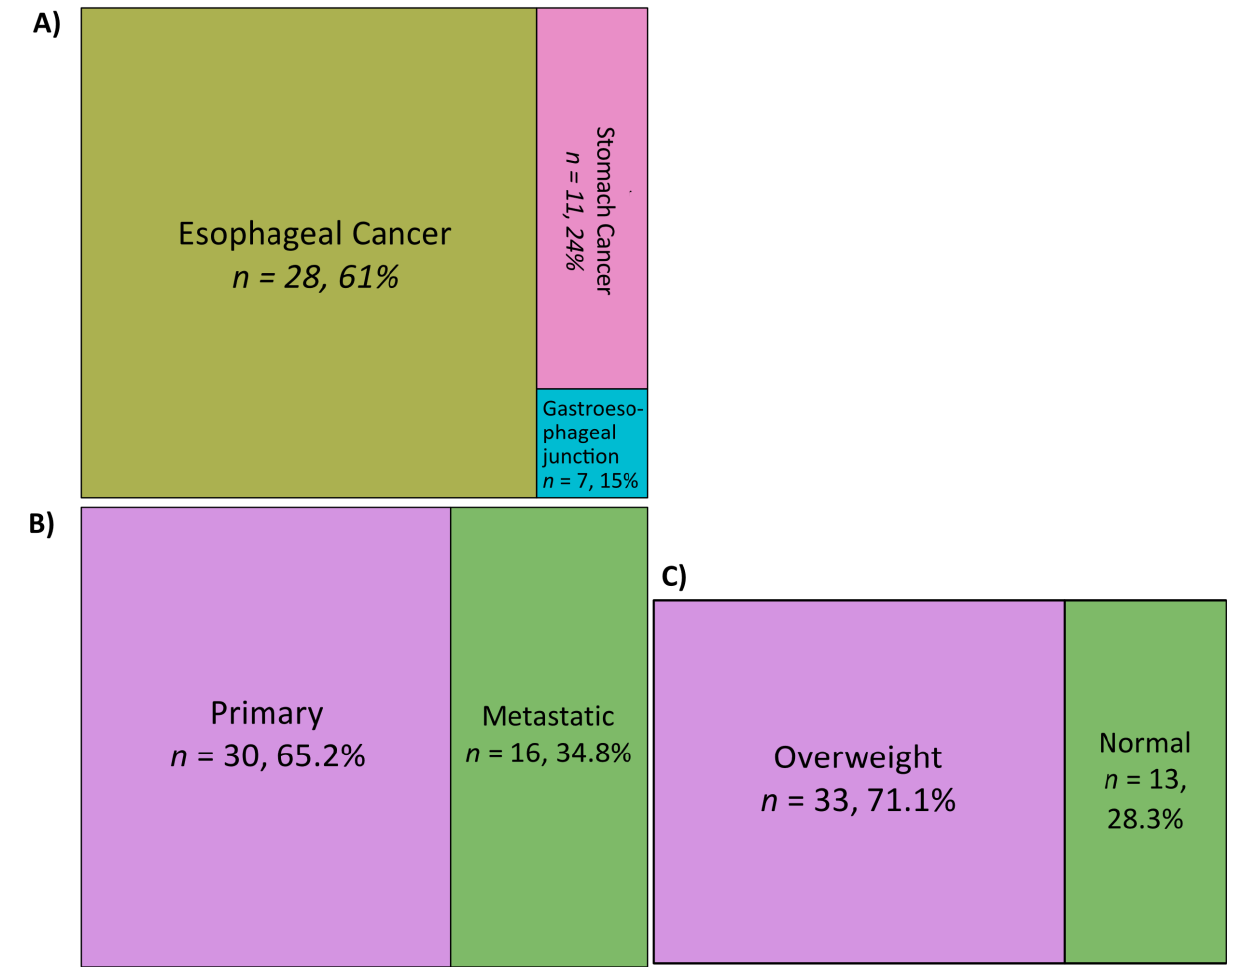
Figure 1. Patient cohort composition by ( A ) cancer type, ( B ) PMR status, and ( C ) BMI status. Table 1. Clinical characteristics of the retrospective cohort.